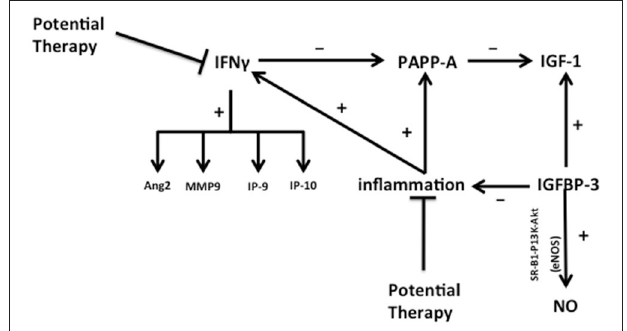
FIGURE 3 | The regulation of inflammation during lung and retina injury in BPD and ROP. The complex interplay of major factors (PAPP-A, IFN γ , IGF-1, IGFBP-3, and NO) in promoting or reducing inflammation and tissue damage is illustrated, and potential targets for therapeutic intervention are identified. IGFBP-3 upregulates NO in both lung microvascular and hematopoietic stem cells (through PI3K-Akt signaling) and promotes IGF-1 activity, thereby decreasing inflammation and endothelial cell death. In addition to nutritional-induced increased IGFBP-3 levels, the interplay of pathways